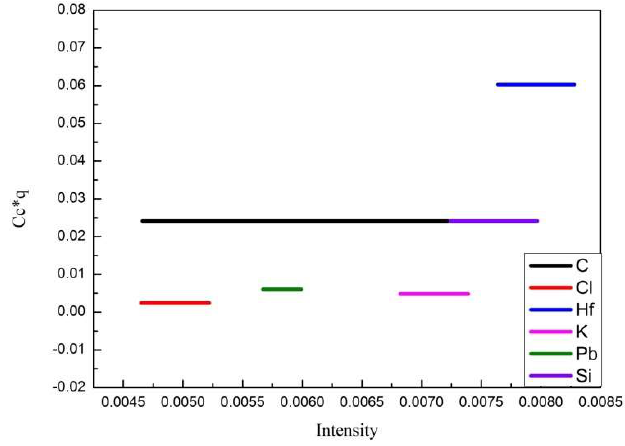
Figure 2. Calibration curves of carbon (156.149), chlorine (134.730), hafnium (286.641), potassium (766.500), lead (220.357), and silicon (288.162).